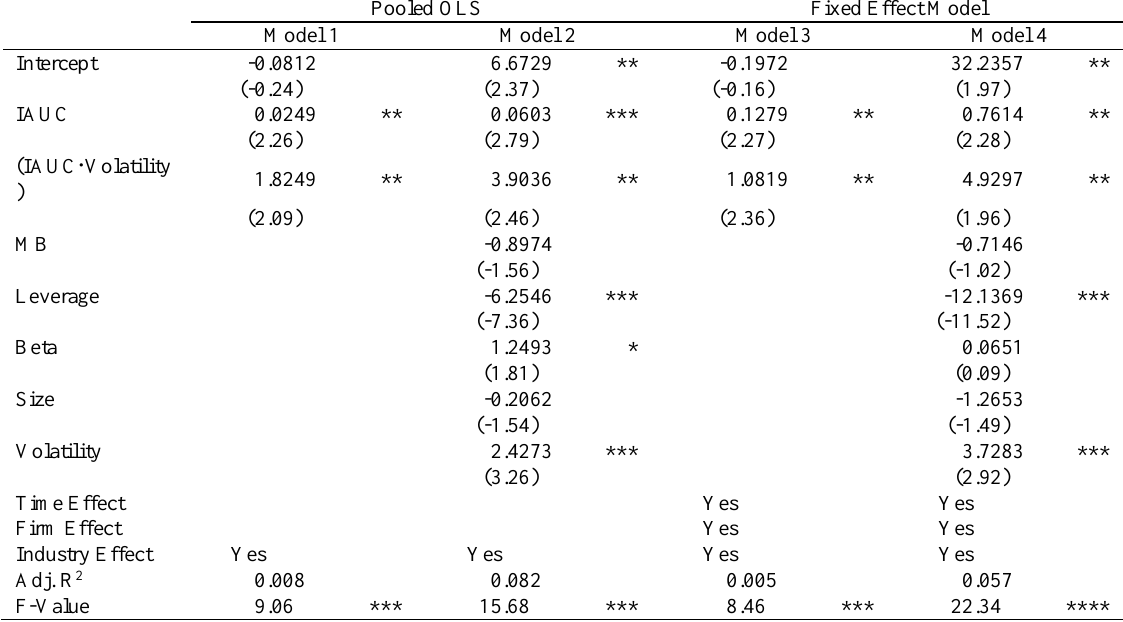
Table 12: Test results on hypothesis 2 for equity cost by using